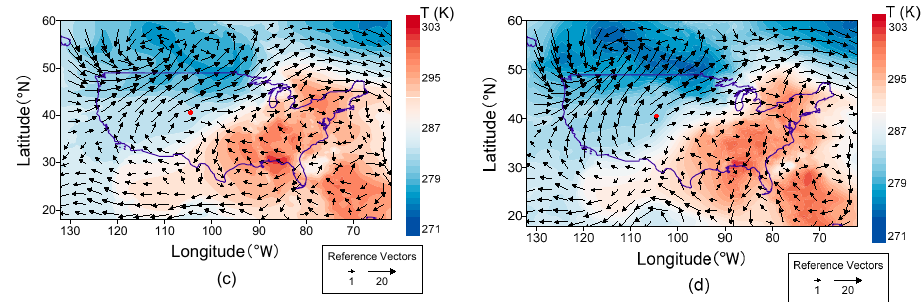
Figure 2. ( a ) 500-hPa and ( b ) 700-hPa geopotential height over North America at 18:00 UT on 30 July 2017, respectively; ( c ) composite of 700-hPa wind field and 850-hPa temperature field at 9:00 UT on 30 July 2017; and ( d ) similar to ( c ) but for 18:00 UT on 30 July 2017. The red dots in the four panels represent the location of the downburst. All the data are from the North American Regional Reanalyis (NARR) dataset.